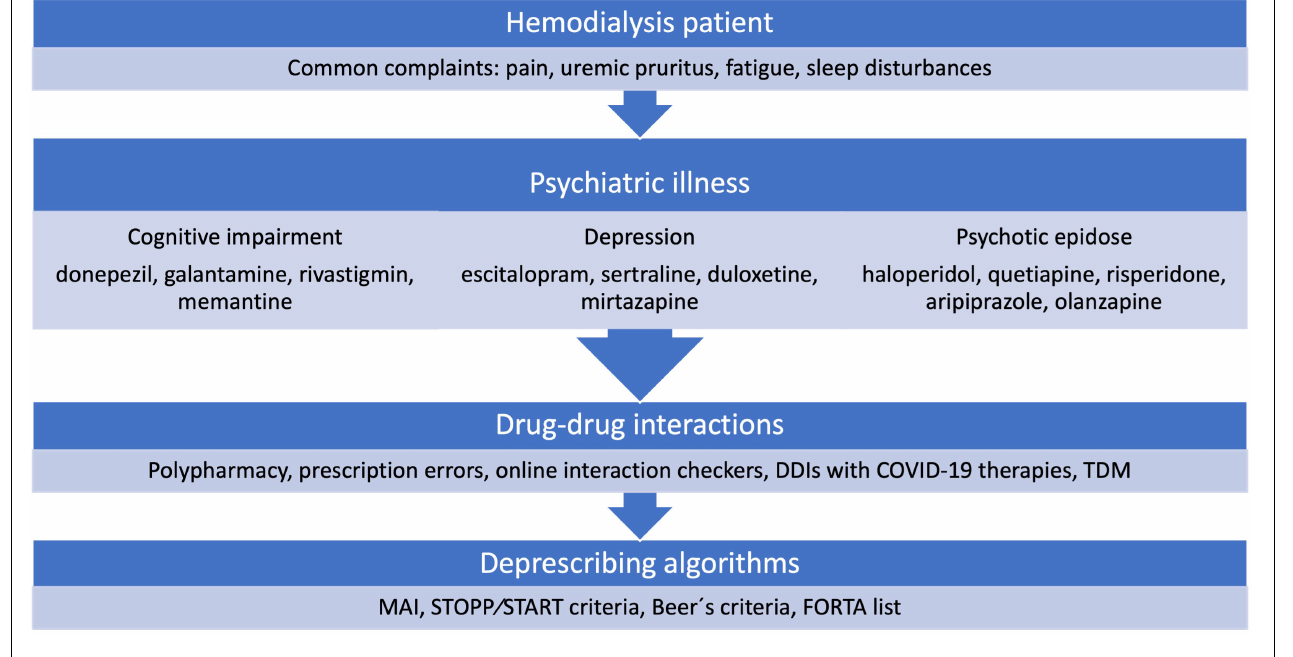
and CYP3A4, CYP2C19, respectively, and advised caution when substrates (10). The impact of HD sessions on changes